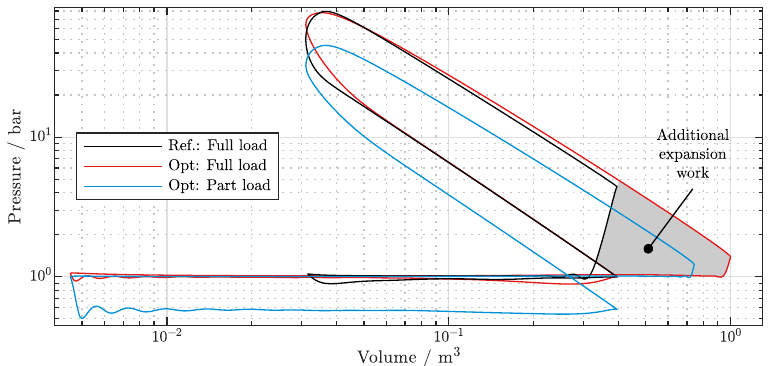
Figure 6. Pressure over volume diagram comparing the full and part load operation of the optimized piston trajectories without acceleration or velocity limit compared to the reference